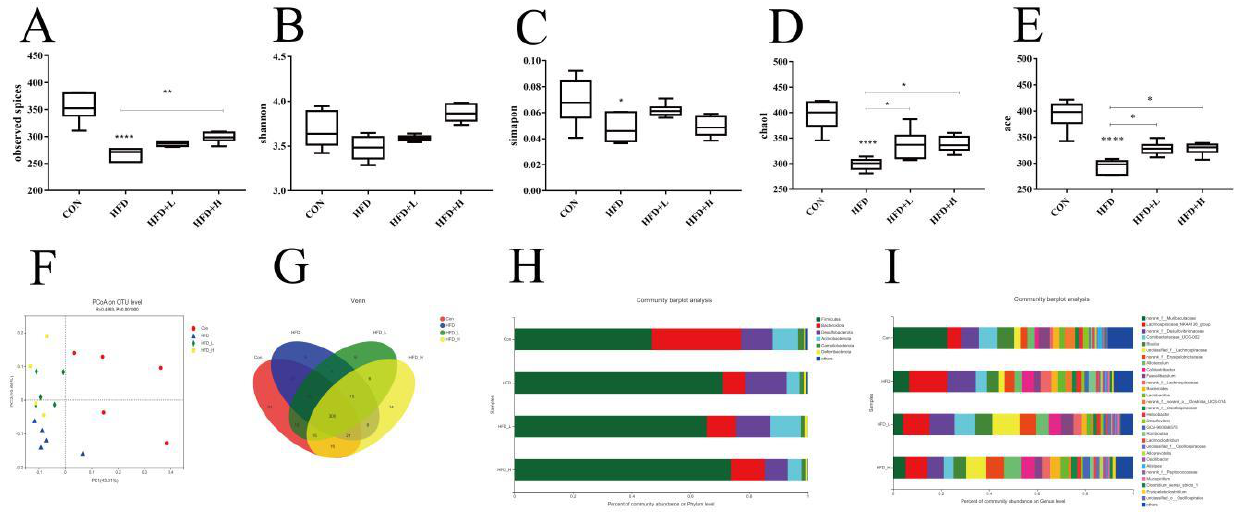
Figure 8. CIP increases the diversity and balance of ( A – E ) and α -diversity: The diversity parameters of observed species, Shannon’s diversity parameter, Simpson’s diversity parameter, Chao1’s diversity parameter, and ACE’s diversity parameter; ( F ) PCoA diagram based on weighted infraction; ( G ) OTUs of Venn diagram between processes; ( H ) relative abundance of intestinal microbiota at phylum level; ( I ) relative abundance of intestinal microbiota at genus level. Data ( n = 5) were shown as mean ± SEM. * p < 0.05, ** p < 0.005, and **** p < 0.0001 compared with the other groups.